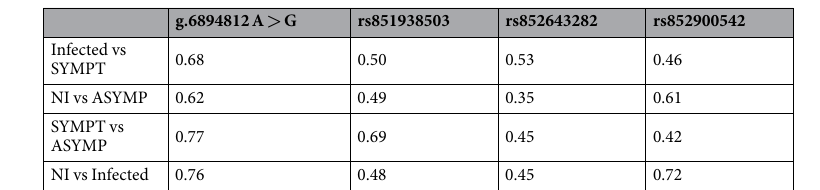
Table 4. p-values of the χ 2 test of independence comparing the allelic frequencies of the 4 SNPs among the phenotypic classes. NI: non-infected dogs, ASYMP: the group of asymptomatic dogs, SYMPT: group of dogs suffering clinical